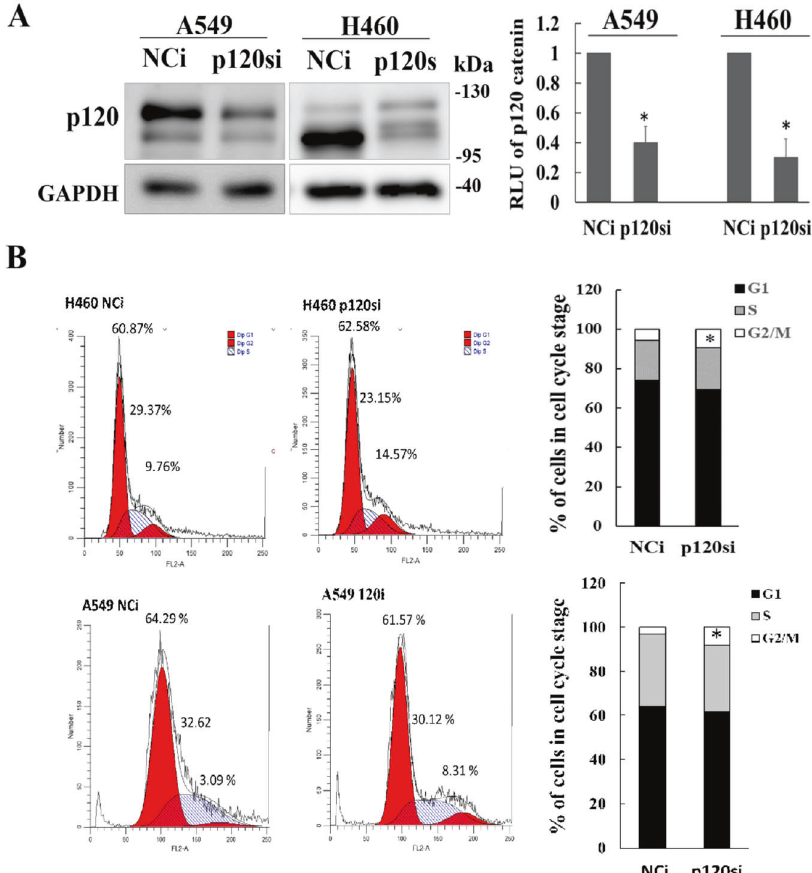
Fig. 1 Downregulation of p120 catenin leads to G2/M arrest in H460/A549 cells. Silencing of p120 catenin by transfection of a speci fi c siRNA decreased the expression of p120 catenin. Lung cancer cells H460/A549 were transfected with NCi (negative control siRNA) or p120si (p120 catenin siRNA) and harvested at 24 h. A Western blotting of cell lysates with the indicated antibodies con fi rmed silencing of p120 catenin using p120si effectively decreased the expression of p120 catenin. The expression levels of p120 catenin and GAPDH were determined by densitometry and are expressed in arbitrary units (RLU, relative luminescent units). B FACS analysis of the cell cycle pro fi le of transfected cells arrested at the beginning of the S phase using a double thymidine block. Cell synchronization was con fi rmed by fl ow cytometry of propidium iodide-stained cells. Representative fl ow cytometry analysis of the DNA content of NCi/p120si-transfected H460/A549 cells (lower panel). The number of cells (arbitrary units) is plotted against DNA content after release from thymidine block and was quanti fi ed using FloJo (right panel); N = 3. * p < 0.05 compared with the cells transfected with the control divided into two cordon-like forms covering the separated chromosomes. During cytokinesis, p120 catenin reorganized into a granular form again. These data indicate that p120 catenin functions at the periphery of chromosomes during mitosis. The interaction of p120 catenin with lumican is enriched at the chromosome periphery layer Lumican, a tubulin-binding protein, is crucial for the formation of spindle fi bers and the assembly of midbodies during cell division [15]. Our previous study has shown the interaction of p120 catenin and lumican. The directly physical interaction between lumican and p120 catenin is proved by co-immunoprecipitation and their co-localizations in the juxta-membrane compartment investigated by co-immuno fl uorescence [14]. To investigate the association of nuclear p120 catenin with lumican during mitosis, we immunos- tained H460 cells with anti-lumican and anti-p120 catenin antibodies to characterize the dynamic equilibrium of spindle microtubule assembly in the mitotic phase and interphase. As shown in Fig. 3A-1, lumican (red) and p120 catenin (green) colocalized (yellow) at the chromosome periphery during mitosis. During prophase, lumican was present at centrosomes and spindle fi bers, and p120 catenin began to dissociate and distribute